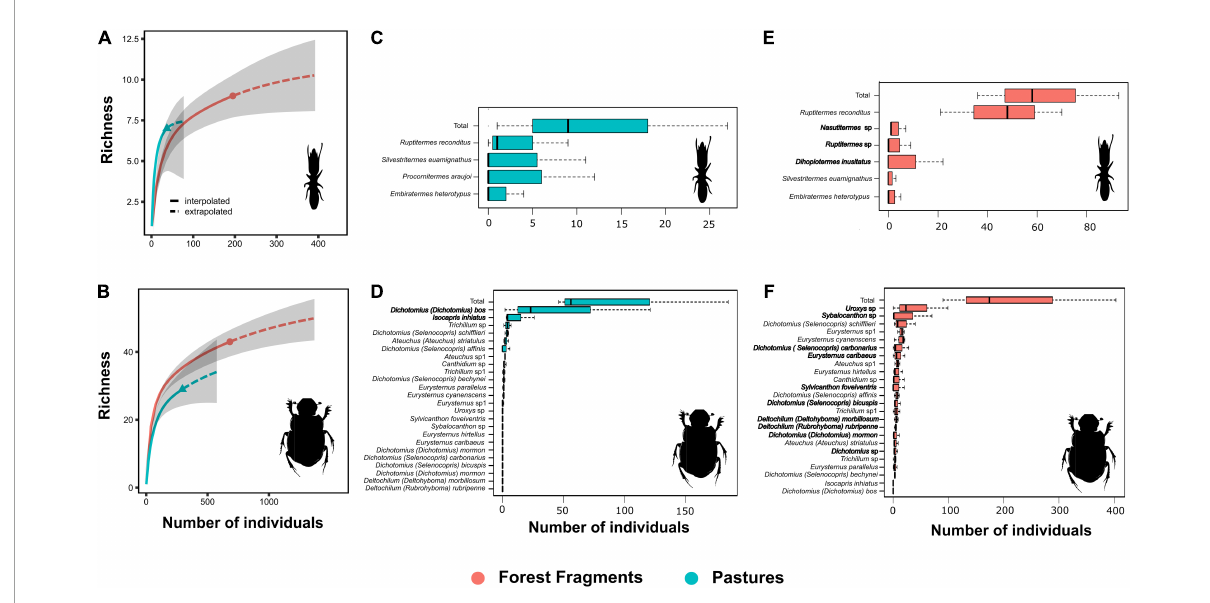
FIGURE2 (A,B) Individual-based species accumulation curves across forest fragments and pastures. Curves were plotted based on data grouped across all sites. The solid line shows predictions based on interpolation and the dashed part shows predictions based on extrapolation. Ninety-five percent confidence intervals are shown as shaded areas. (C–F) Species abundance for pastures (blue boxes) and forest fragments (red boxes). Boxplots report median, upper and lower quartiles, and maximum and minimum values. Habitat specialists are marked in bold.